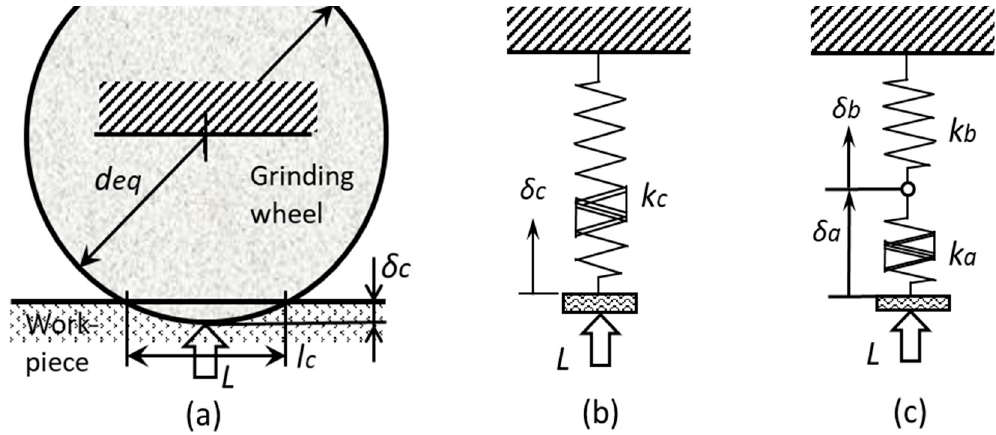
Figure 14. Modeling of the contact sti ff ness of the grinding wheel. ( a ) Contact of wheel with workpiece; ( b ) Model of contact sti ff ness; ( c ) Series connection of linear and non-linear springs.